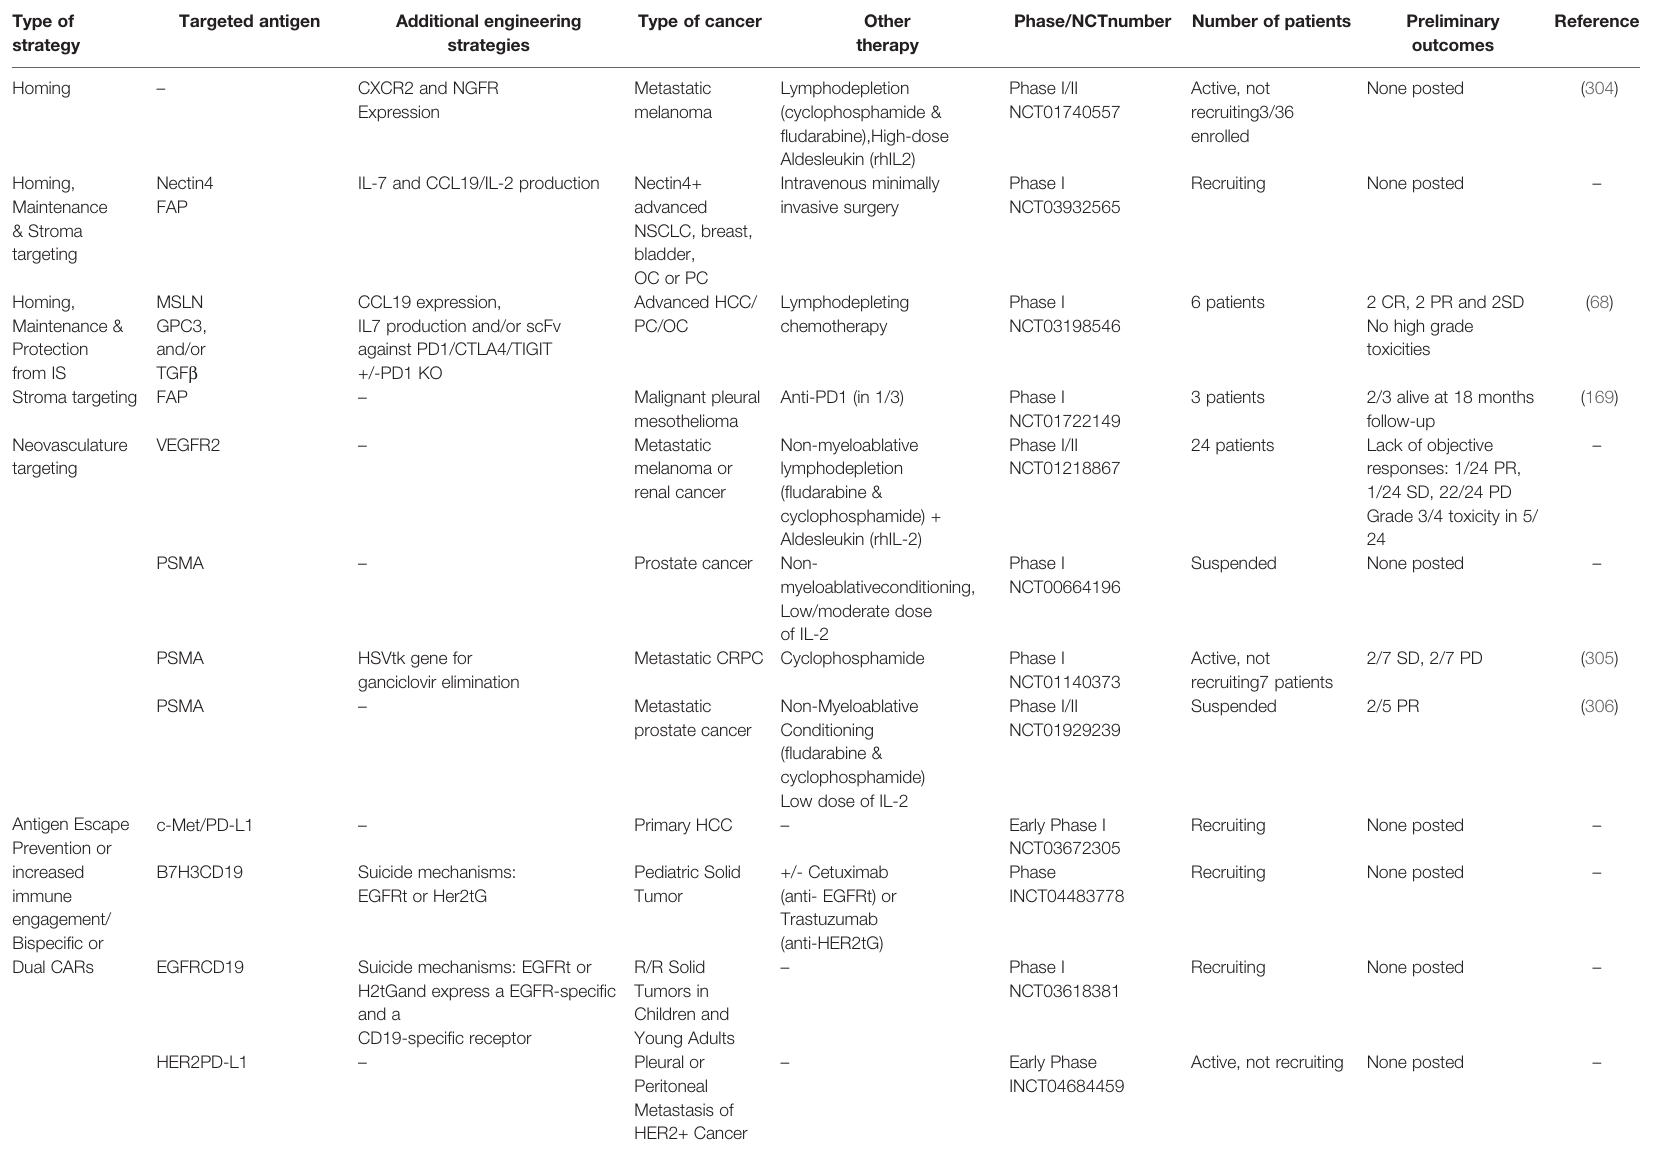
TABLE 10 | Summary of clinical trials on CAR-T cells designed to improve tumor homing and penetration, CAR-T cell persistence and resistance to immunossupresssion in solid